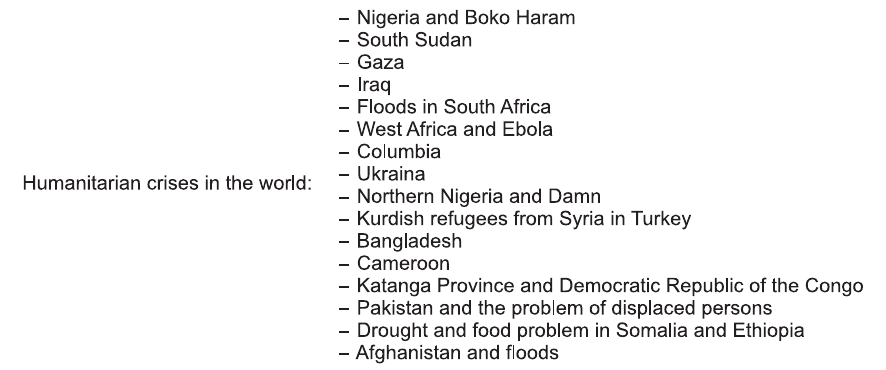
Figure 2. Humanitarian crises in the world